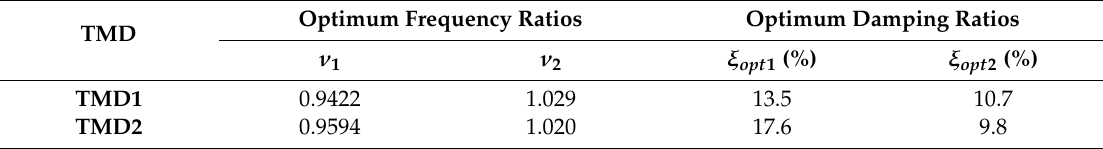
Table 2. Optimum parameters of 2DOFs TMDs.